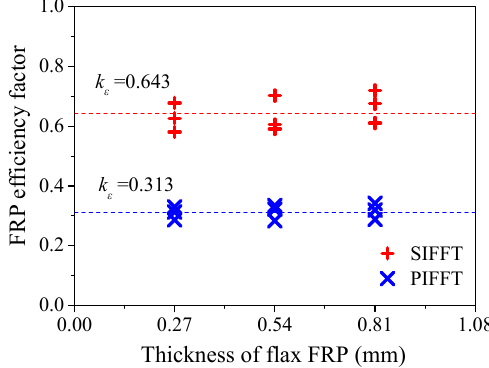
Figure 18. Strain efficiency factor in PIFFT and SIFFT specimens.